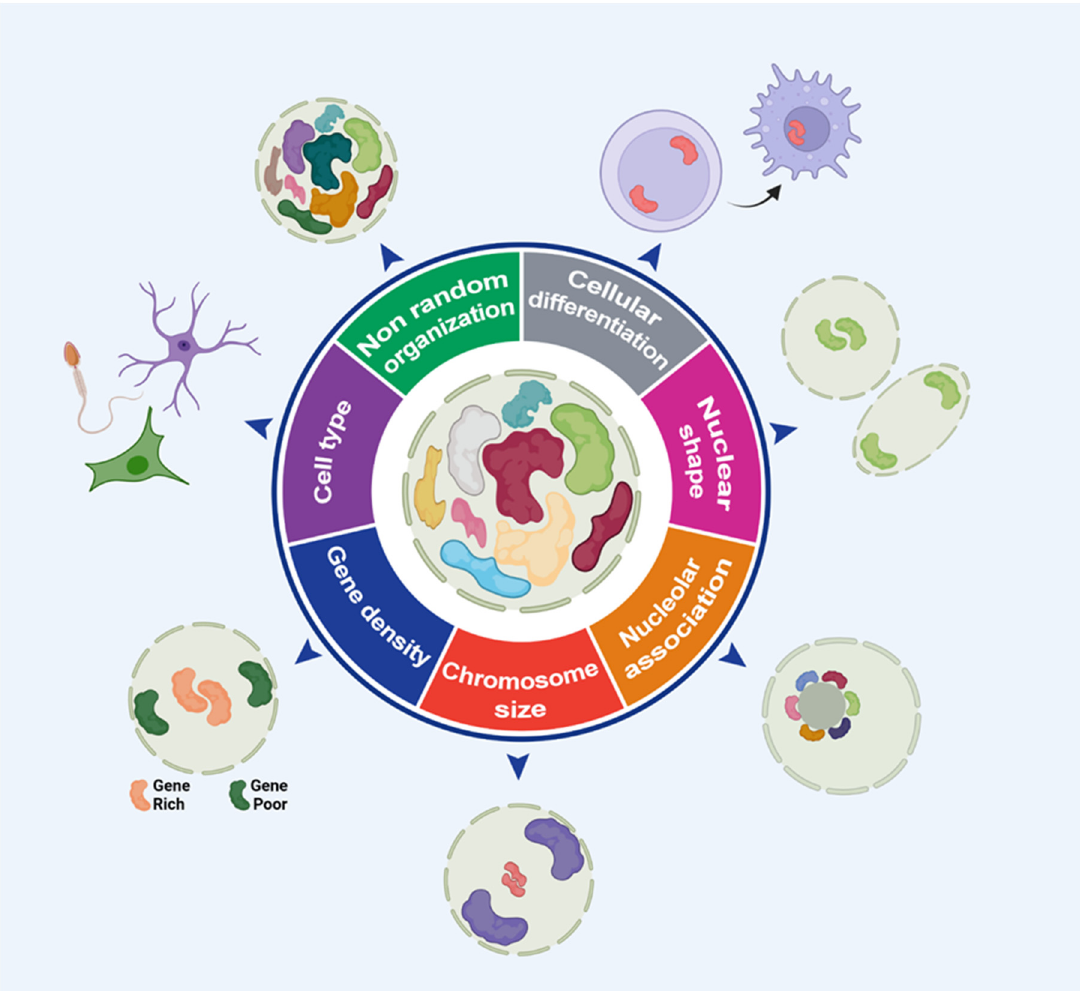
Figure 2. Chromosome territories: established concepts. Overview of chromosome organization regarding different proposed models of CT etiology. The non-random chromosome organization varies according to the cellular differentiation status, nuclear shape, nucleolar-associated chromosomes, chromosome size, gene density, and cell type. Chromosome spatial organization is emerging as an important mechanism of gene expression regulation and key determinant of cell fate. Image inspired by hallmarks of cancer, 2011 [72].